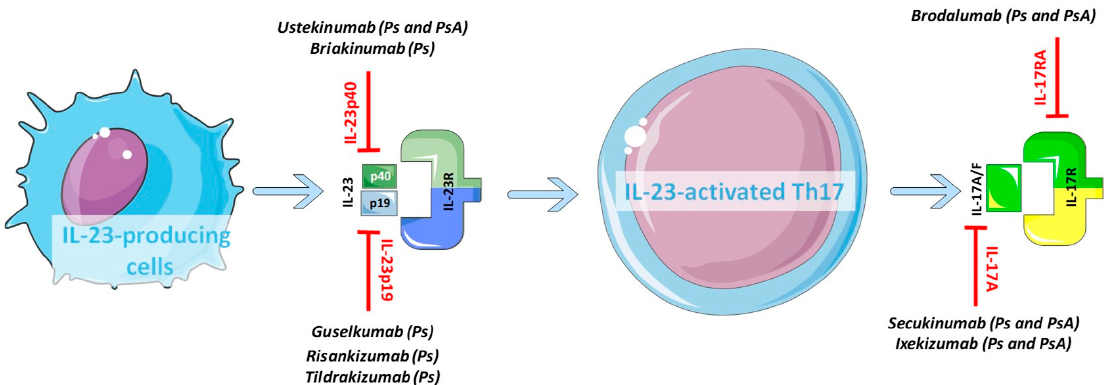
Figure 2. Biologics targeting the IL-23/IL-17 axis in Psoriasis (Ps) and Psoriatic Arthritis (PsA). Specific monoclonal antibodies targeting IL-23p40, IL-23p19, IL-17A or its receptor IL-17R have been developed and are currently used in clinical practice or still tested inclinical trials (see Table 1).